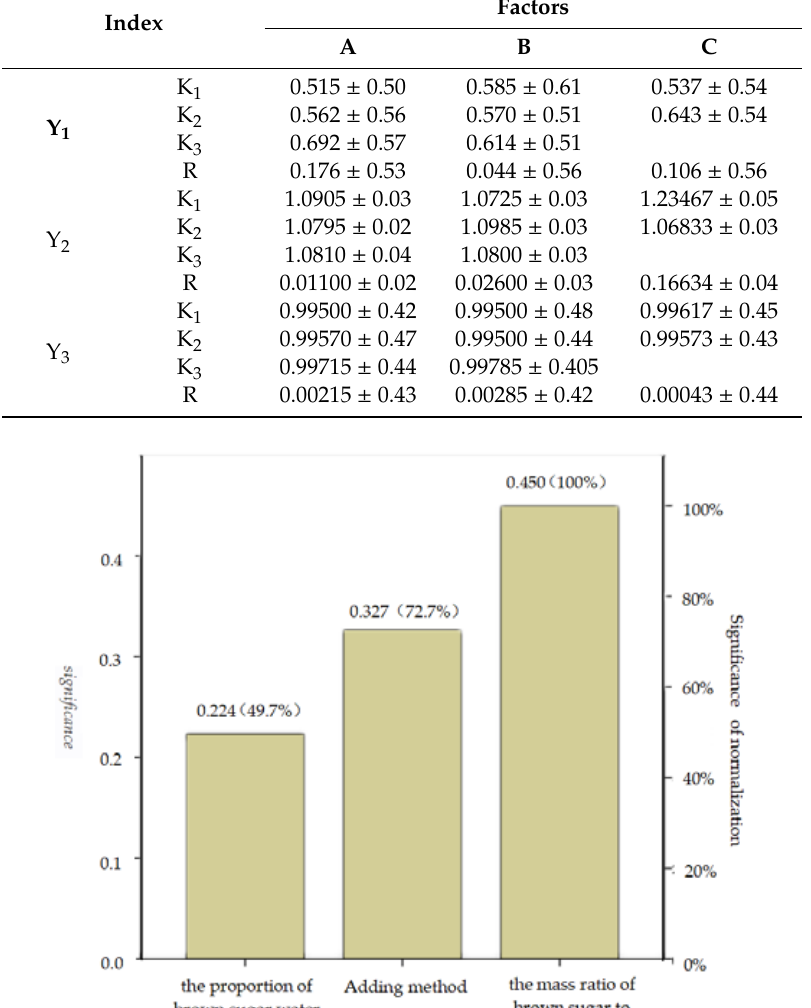
Table 3. Range analysis table.